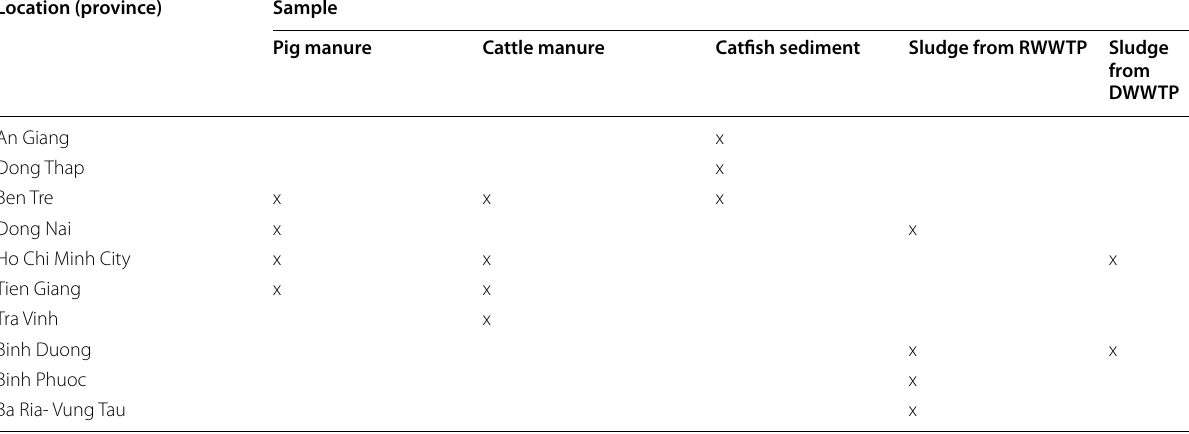
Table 2 Sampling area according to source of